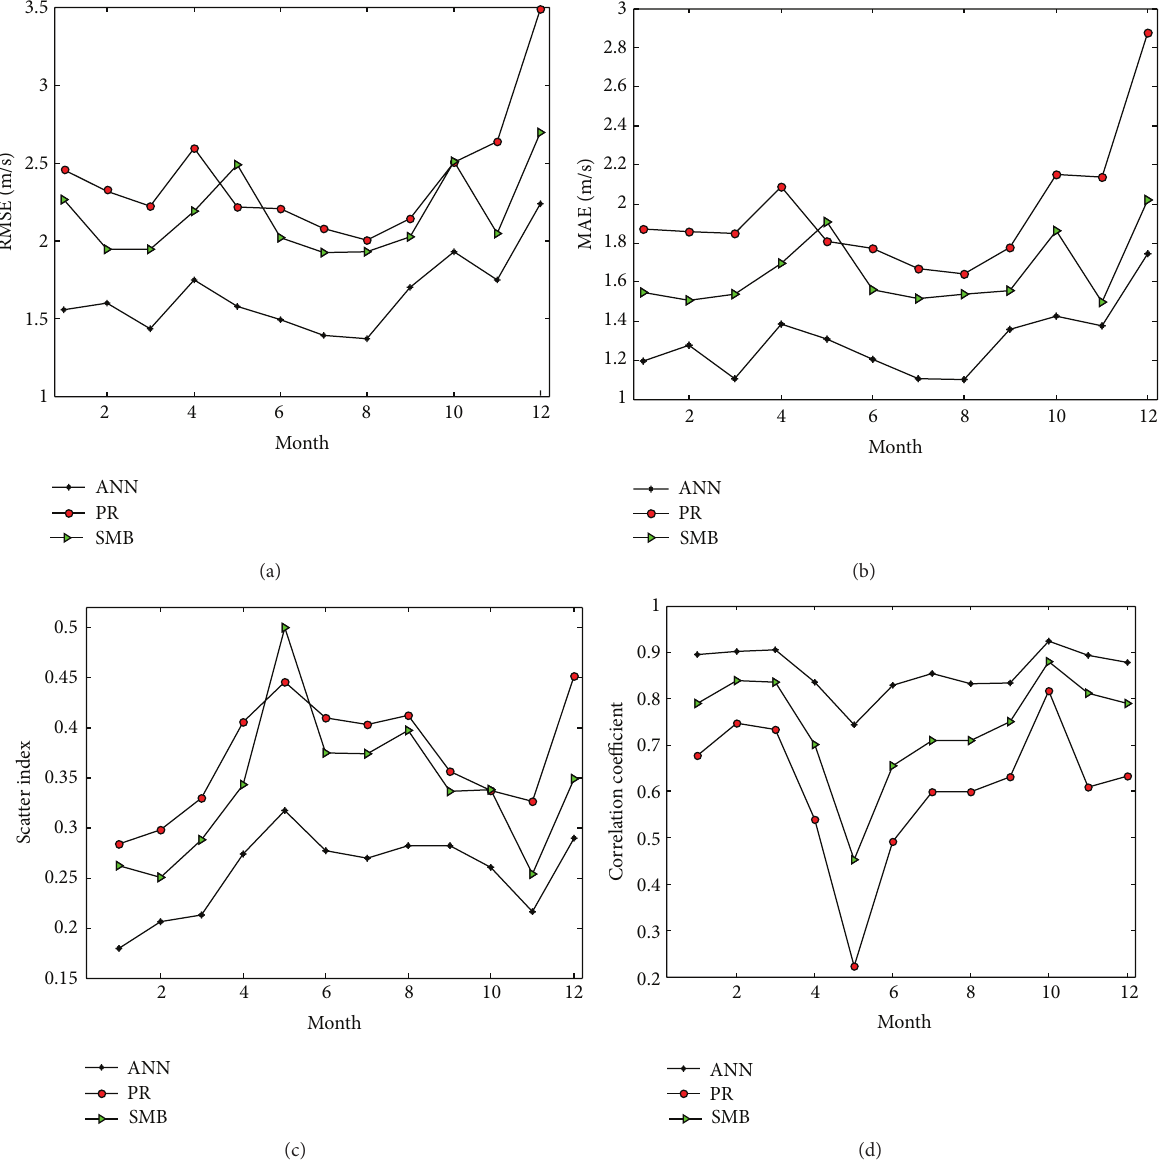
Figure 4: Wind speed estimated by the buoy data per month in 2012. (a) RMSE. (b) MAE. (c) CC. (d) SI.